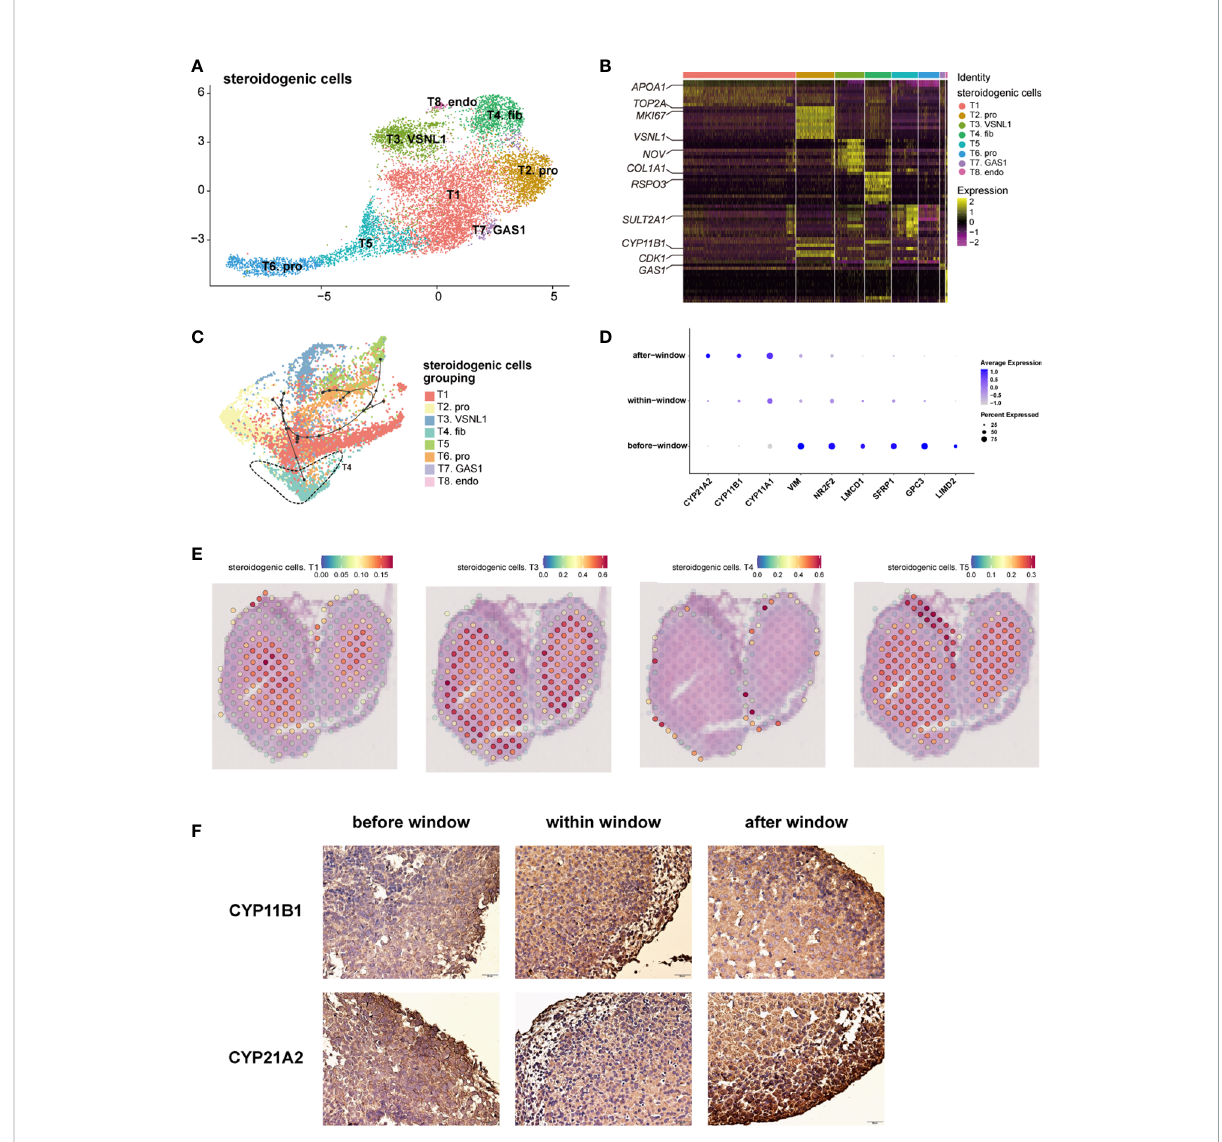
FIGURE 2 Landscape and characteristics of fetal adrenal gland steroidogenic cells. (A) Uniform manifold approximation and projection analysis visualization of steroidogenic cells for 10× Genomics data (n = 10,651). (B) Heatmap of the top 10 differentially expressed genes (DEGs) between steroidogenic cell populations (n = 10,651). Color scale: yellow, high expression; purple, low expression. Detailed cell information and DEGs can be found in Table S3. (C) Differentiation of the trajectory of steroidogenic cells using Dyno. The arrow direction indicates the trajectory of cell differentiation. (D) Dot plots of differential gene expression of three-stage steroidogenic cell groups (before, within, and after sexual differentiation). Detailed DEGs of steroidogenic cells between sexes before, within, and after the window of sexual differentiation can be found in Tables S7-9. (E) Visualization of the spatial transcriptome shows the location of T1 and T3, T4 and T5 steroidogenic cells in 8GW fetal adrenals. (F) Immunohistochemical staining of CYP11B1 (up) and CYP21A2 (down) in the fetal adrenal glands spanning the window of sexual differentiation. Scale bar, 20 m m. n =